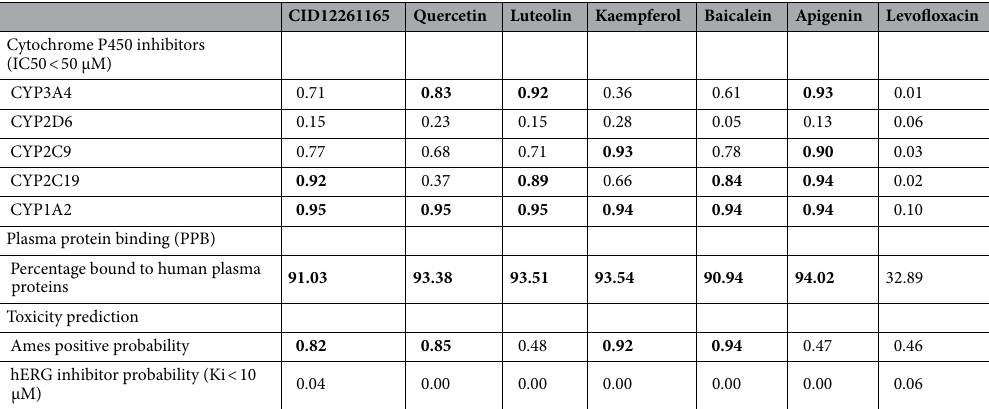
CID12261165 Quercetin Luteolin Kaempferol Baicalein Apigenin